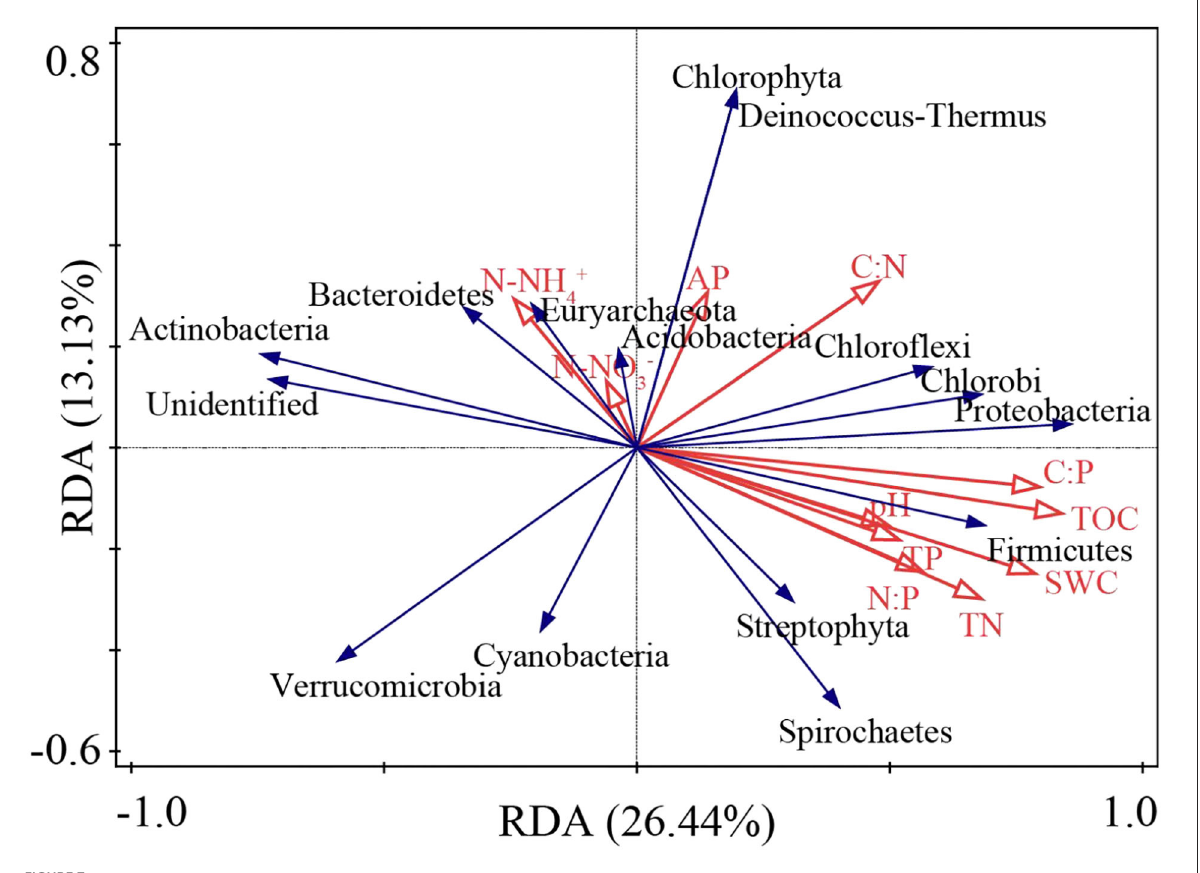
FIGURE7 RDA ranking of soil physicochemical indexes and nitrogen-fixing bacteria